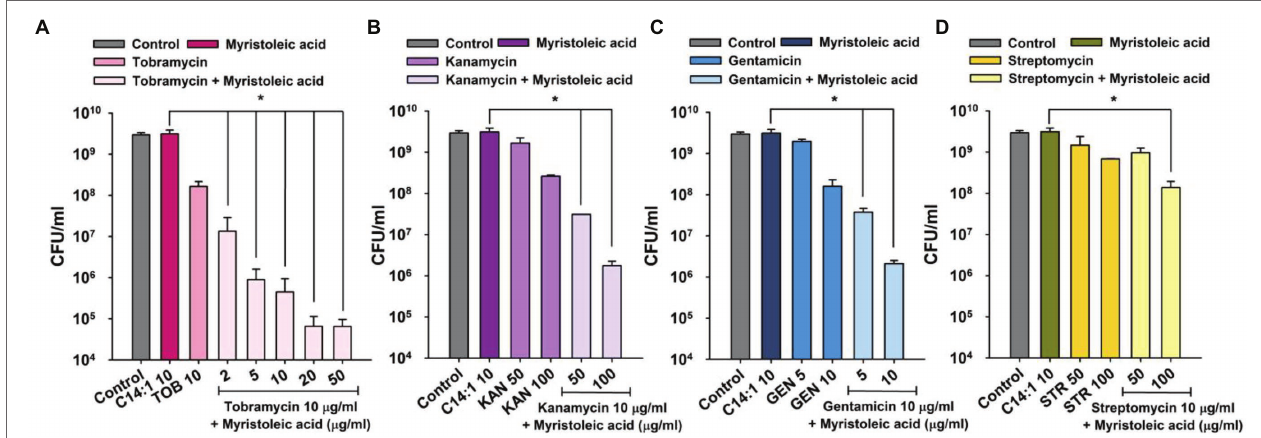
FIGURE 2 | Synergistic antimicrobial activities of myristoleic acid and aminoglycoside antibiotics against Staphylococcus aureus . Cell survivals were measured 1 h after treating MSSA 6538 with myristoleic acid (10 μ g/ml) and/or tobramycin (A) , kanamycin (B) , gentamicin (C) , or streptomycin (D) . * p < 0.05 vs. myristoleic acid- treated controls. TOB; tobramycin, KAN; kanamycin, GEN; gentamicin, STR; streptomycin, C14:1; myristoleic acid, Control; untreated control.